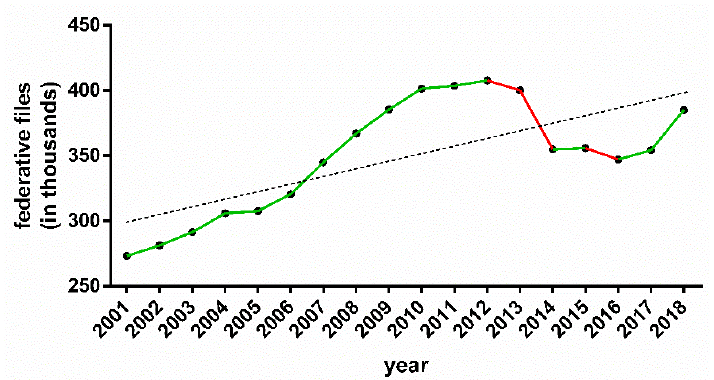
Figure 1. Evolution of the number of basketball players in Spain in recent years.